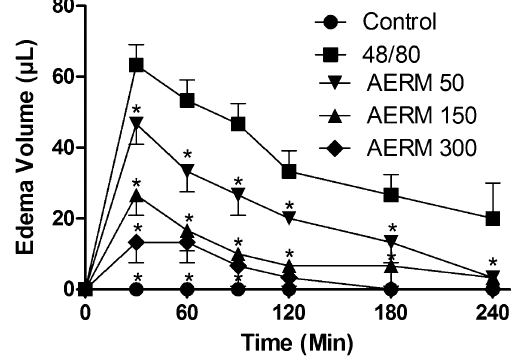
Fig. 6 Monitoration of paw edema induced by 48/80. The analysis showed an inhibition when treatments were injected with AERM. Two-way ANOVA with Bonferroni as a post test ( p \ 0.001). Statistical differences relative to the compound 48/80 (filled squares) are marked with